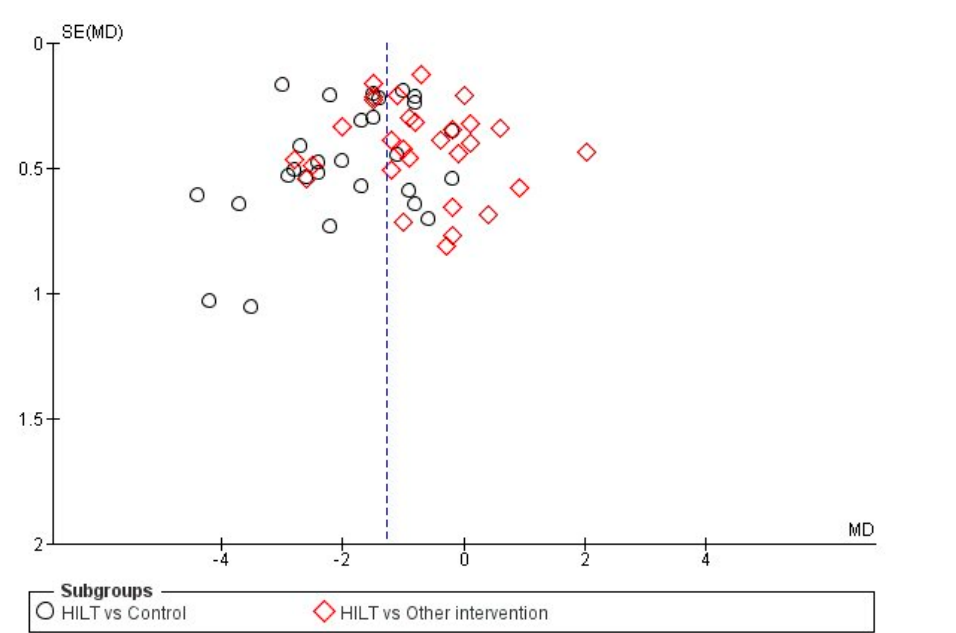
Figure 3. Funnel plot for the comparison of high-intensity laser therapy (HILT) vs. control/another intervention for pain outcome as measured on a VAS .